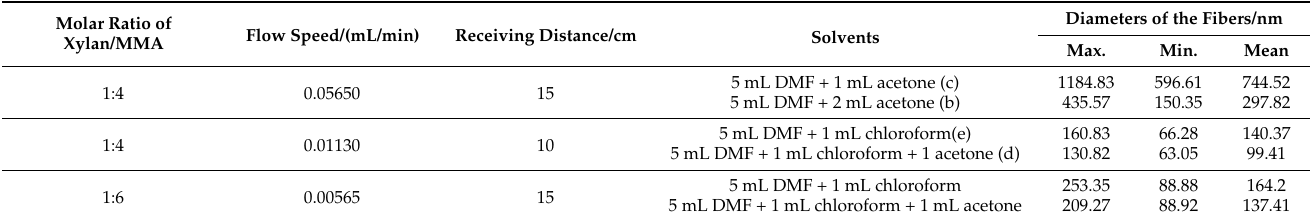
Table 1. The effect of solvents on the diameters of the electrospun fibers.